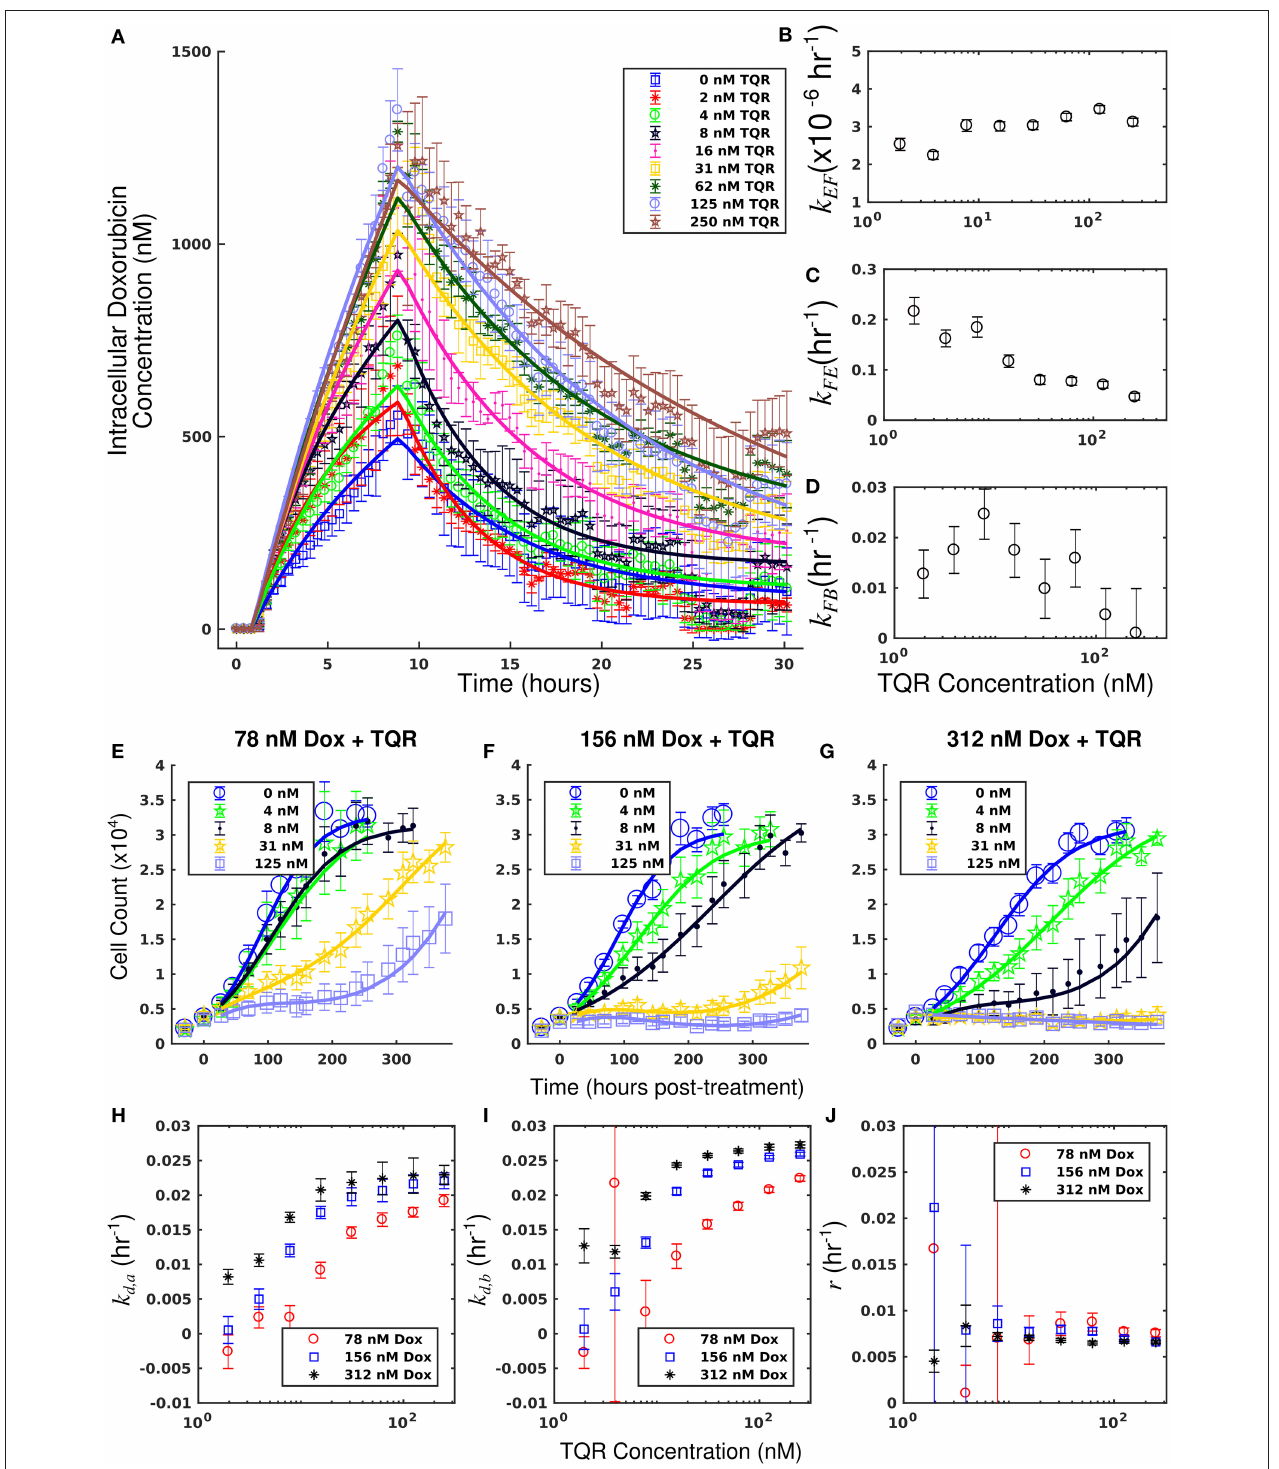
FIGURE 2 | Doxorubicin and TQR combination studies in the MDA-MB-468 MDR1 cell line. Timecourses of the mean intracellular concentration of doxorubicin with corresponding standard deviations are shown for each treatment condition in (A) . Doxorubicin accumulation increases along with TQR concentrations. Equations (1–3) were fit to the data, and the best-fit models are overlaid on the data (smooth lines) in a. Model parameter fits corresponding to the best-fit models are shown in (B–D) . Similar k EF and k FB vales are observed across all TQR concentrations. There is a trend of decreasing k FE values with increasing TQR concentrations